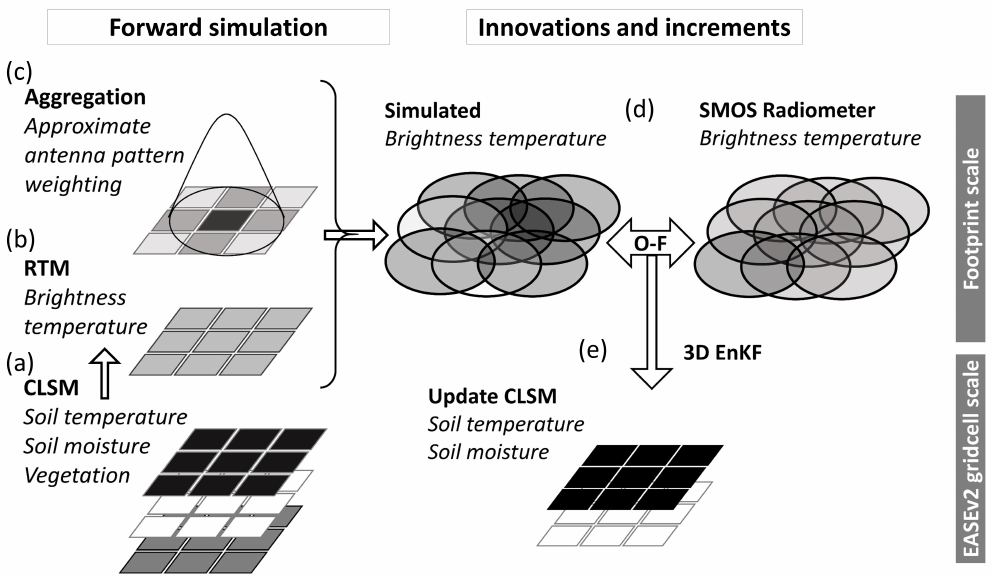
Figure 1. Flowchart of Tb assimilation. The forward simulation consists of (a) land surface model simulations and (b) Tb simulations on the 36km EASEv2 grid. The Tb simulations are subsequently (c) aggregated using weights based on an approximate antenna pattern. The resulting footprint-scale brightness temperature observation predictions are compared to (d) SMOS observations to calculate innovations (O–F) at the footprint scale. (e) The three-dimensional EnKF maps the footprint-scale innovations to the 36km EASEv2 grid based on the modeled error correlations between the footprint-scale Tb and the 36km soil moisture and soil temperature state variables (per Eqs. 1 and